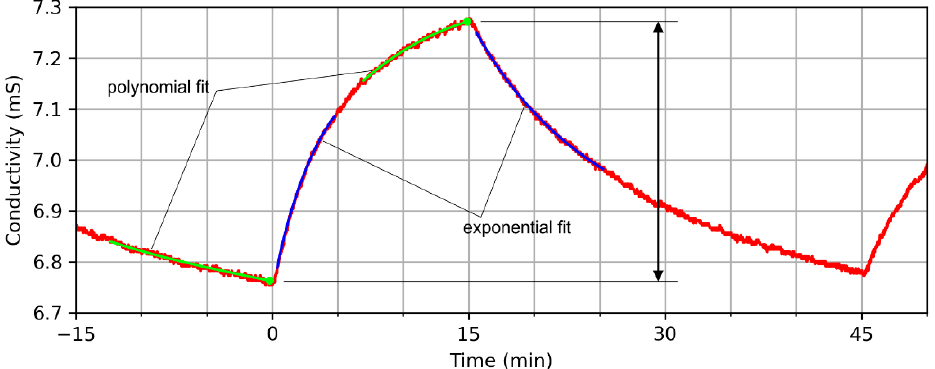
Figure 6. Enlarged view of typical transient response of a graphene-based sensor (S2) to 60 ppb of O 3 . Curve fitting (as indicated) was applied to certain sections of the data to extract characteristic features for machine learning.